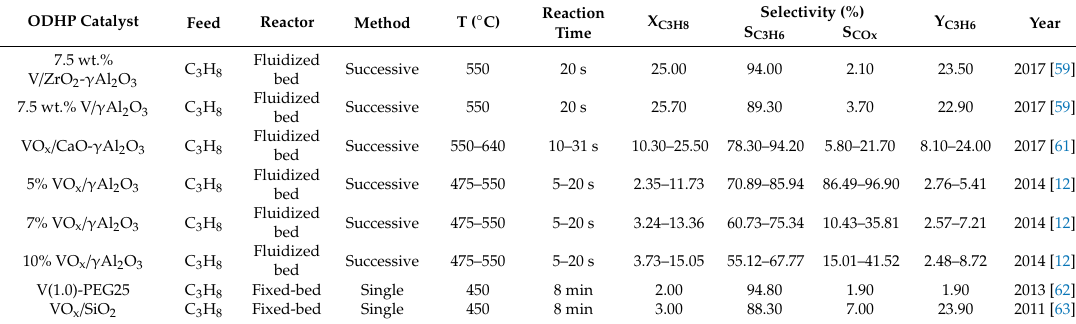
Table 3. Propane ODH catalysts.